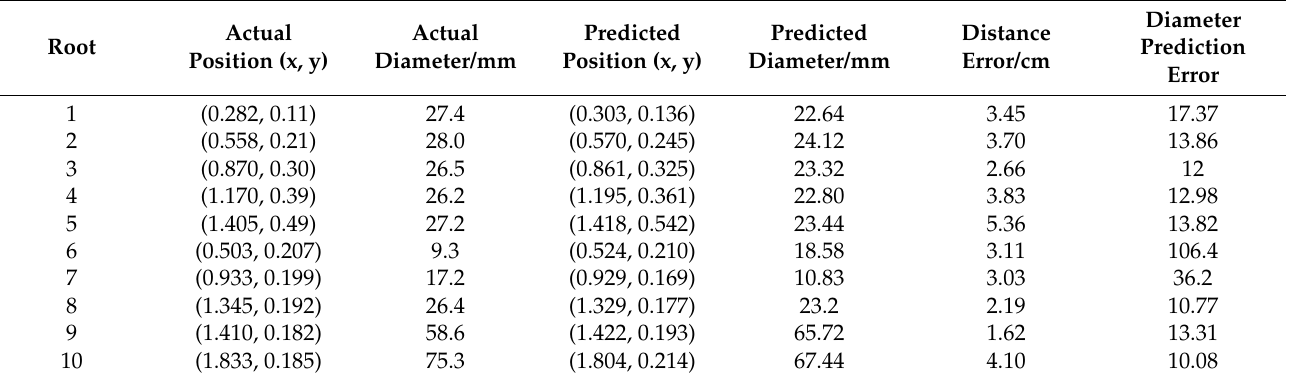
Table 3. Pre-buried root test results.